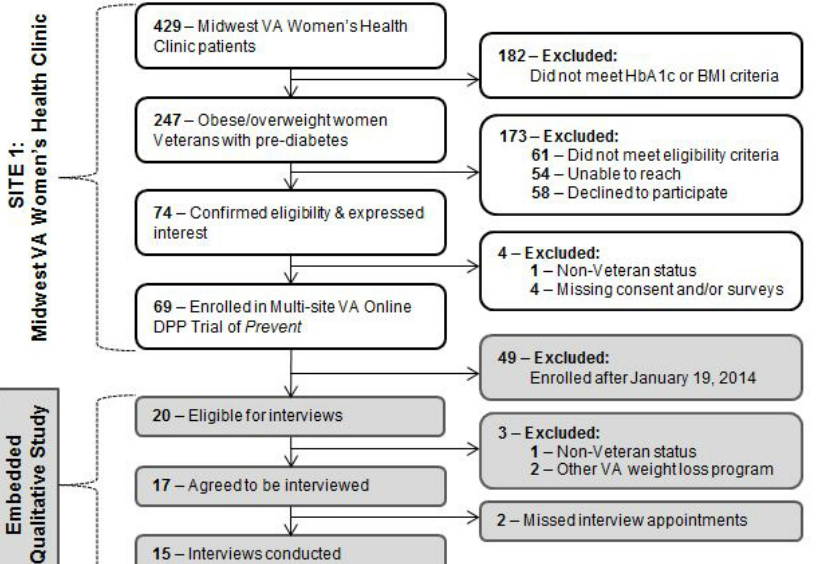
Figure 3. Study recruitment